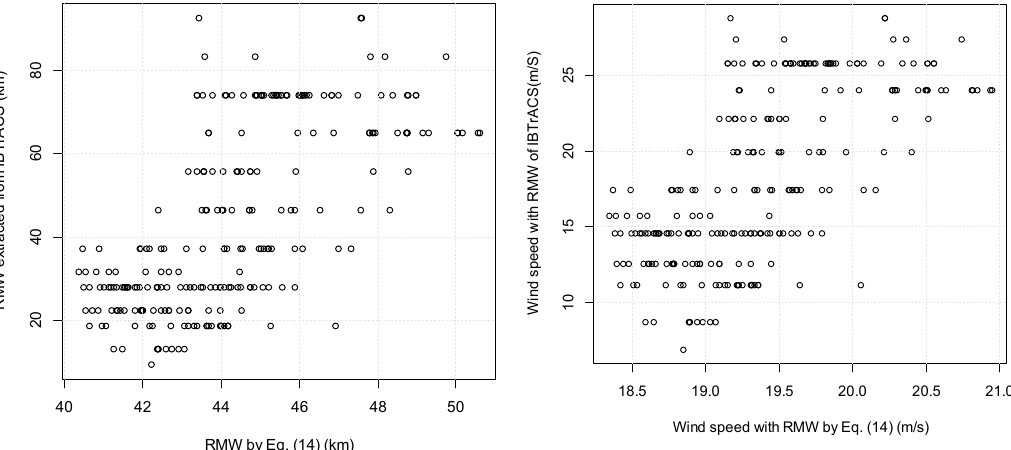
Figure 3. Comparison of the radius of maximum winds (RMW) by Equation (14) against RMW from IBTrACS ( left ) and comparison of wind speed deduced from the two RMWs ( right ). Table 1. Quantile statistics of the radius of maximum winds (RMWs) and relevant wind speed reconstructed by H10. WSP: wind speed.